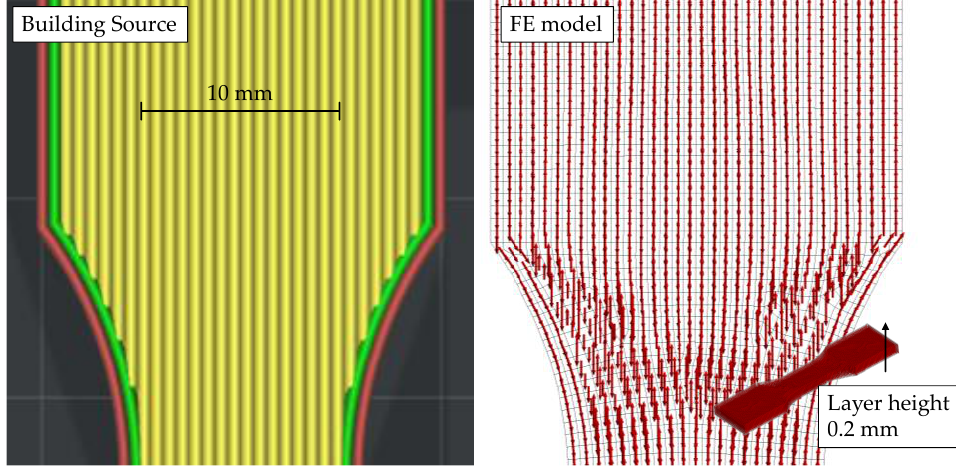
Figure 4. Building source (G-Code, left ) mapped to FE model ( right ) for the first specimen (F0°) using the approach presented by the authors [39].